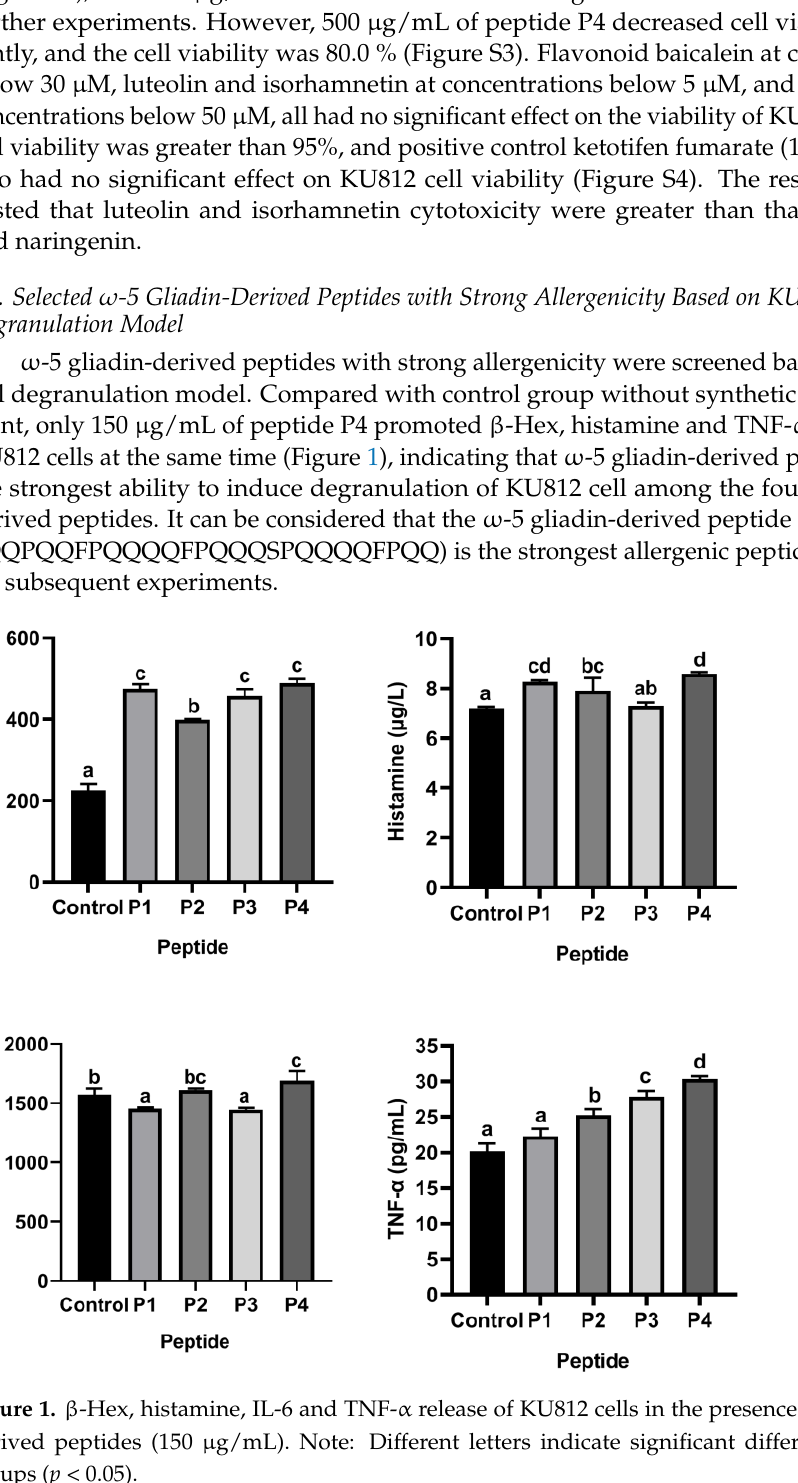
derived peptides (150 µ g/mL). Note: Different letters indicate significant differences between Figure 1. β -Hex, histamine, IL-6 and TNF- α release of KU812 cells in the presence of ω -5 gliadin- groups ( p < derived peptide s (150 μg /mL). Note: Different letters indicate significant differences between groups ( p < 0.05).